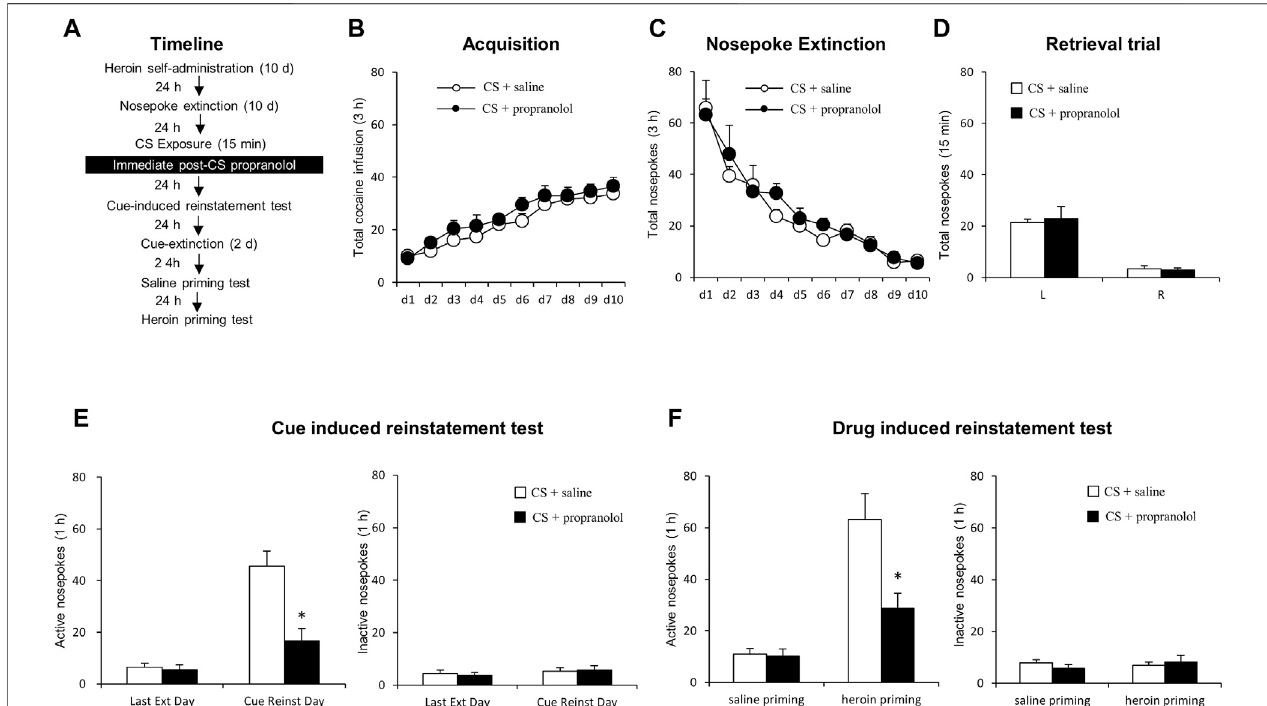
FIGURE 1 | Immediate post-CS reactivation propranolol treatment reduces subsequent cue-induced and heroin-primed reinstatement of heroin seeking. (A) Schematicrepresentation oftheexperimental procedure. (B) Total number ofheroin infusionsacrossacquisition ofheroin self-administration. (C) Totalnumber ofactive nosepokeresponsesacrossextinctionsessions. (D) Nosepokeresponsesduringareactivationtrial. (E) Active (left) andinactive (right) nosepokeresponsesduringthe last extinction session and the cue-induced reinstatement test. (F) Active (left) and inactive (right) nosepoke responses during the saline- or heroin-primed reinstatement